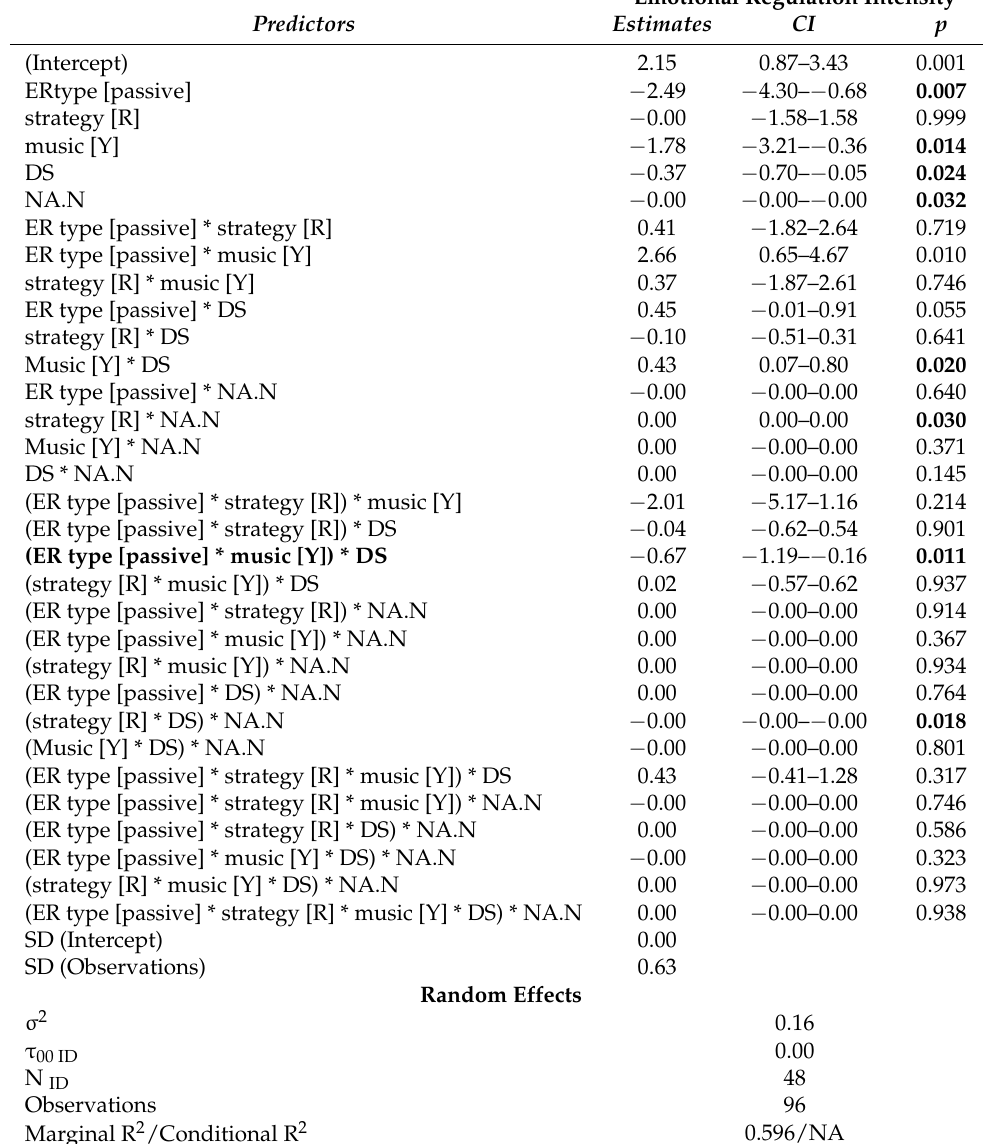
Table A4. Effects of music, strategies, ER type, NA.N and DS (working memory) on emotional regulation